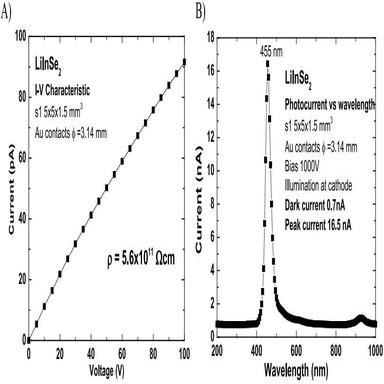
Two samples of polished LiInSe2 with two parallel faces.